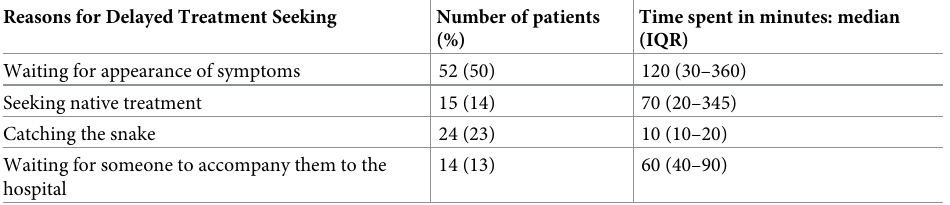
Table 2. Reasons for presentation delays and the time spent for the delays of presentation in in 105 patients who intentionally delayed treatment seeking. Reasons for Delayed Treatment Seeking